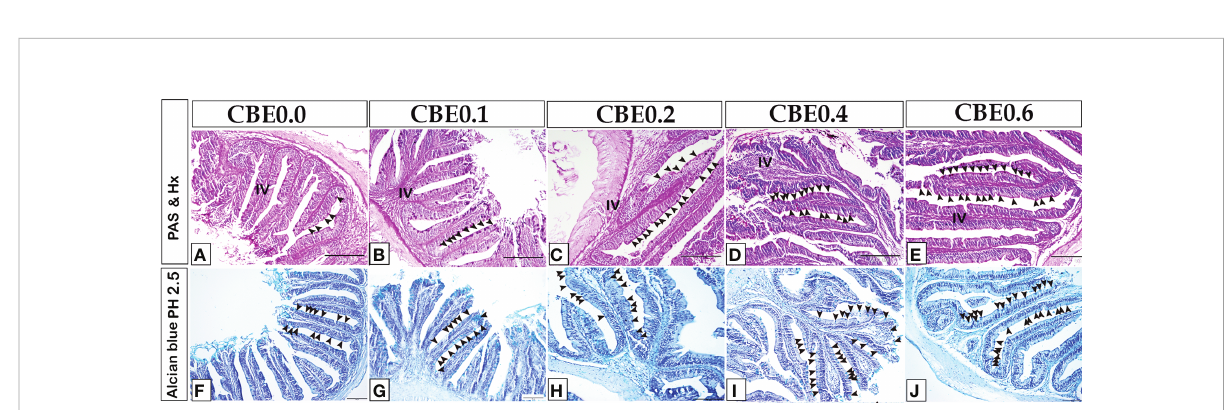
FIGURE 4 The number of goblet cells and the height of intestinal villi increased in response to various CBE dosages, as shown by paraf fi n sections of the middle intestine stained with PASHX (A – E) for neutral mucin in goblet cells and Alcian blue pH 2. 5 (F-J) for acid mucin inside the goblet